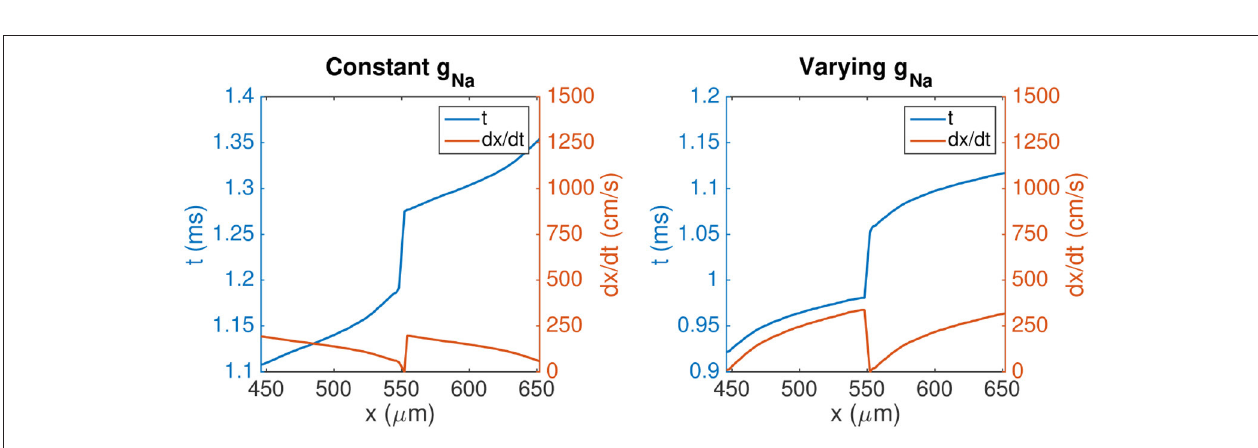
the activation curve flattens out toward the end of the cells, corresponding to an increased conduction velocity toward the cell